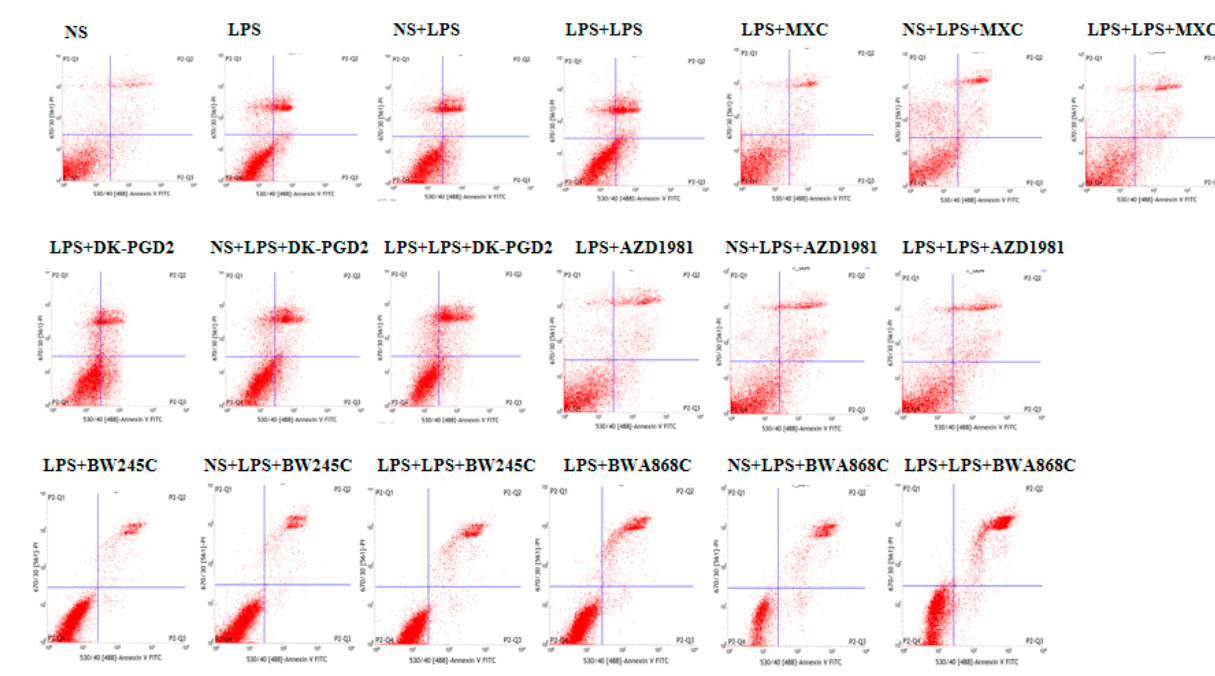
Figure 10. Determination of apoptosis cells with flow cytometry.